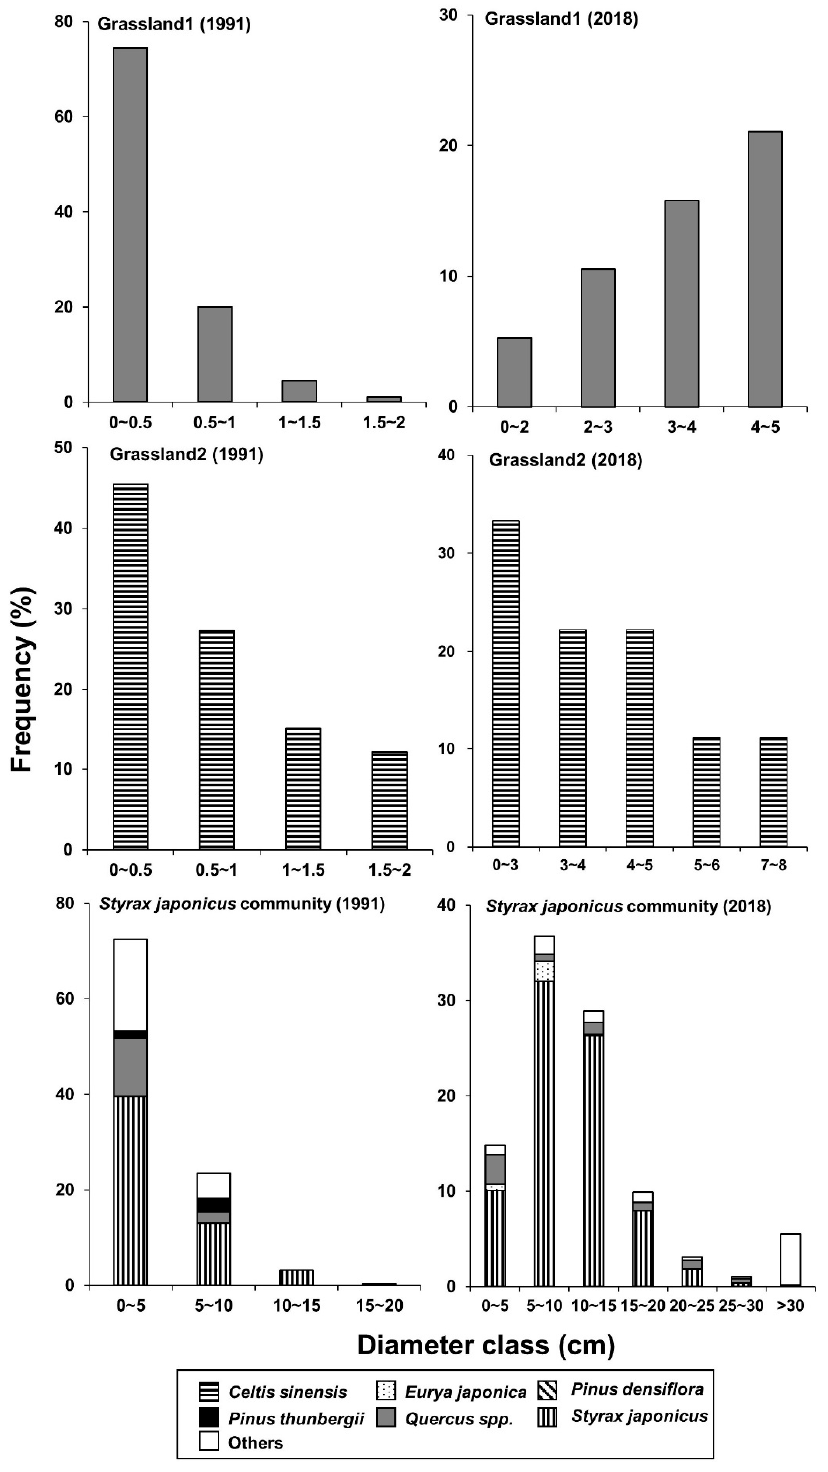
Figure 4. Cont Figure 4. Frequency distribution diagrams of diameter class of tree and two shrub species in three vegetation types: grassland 1 ( M. sinensis var. purpurascens community), grassland 2 ( P. americana community), shrubland ( S. japonicus community), and forest ( P. densiflora community , P. thunbergii community).